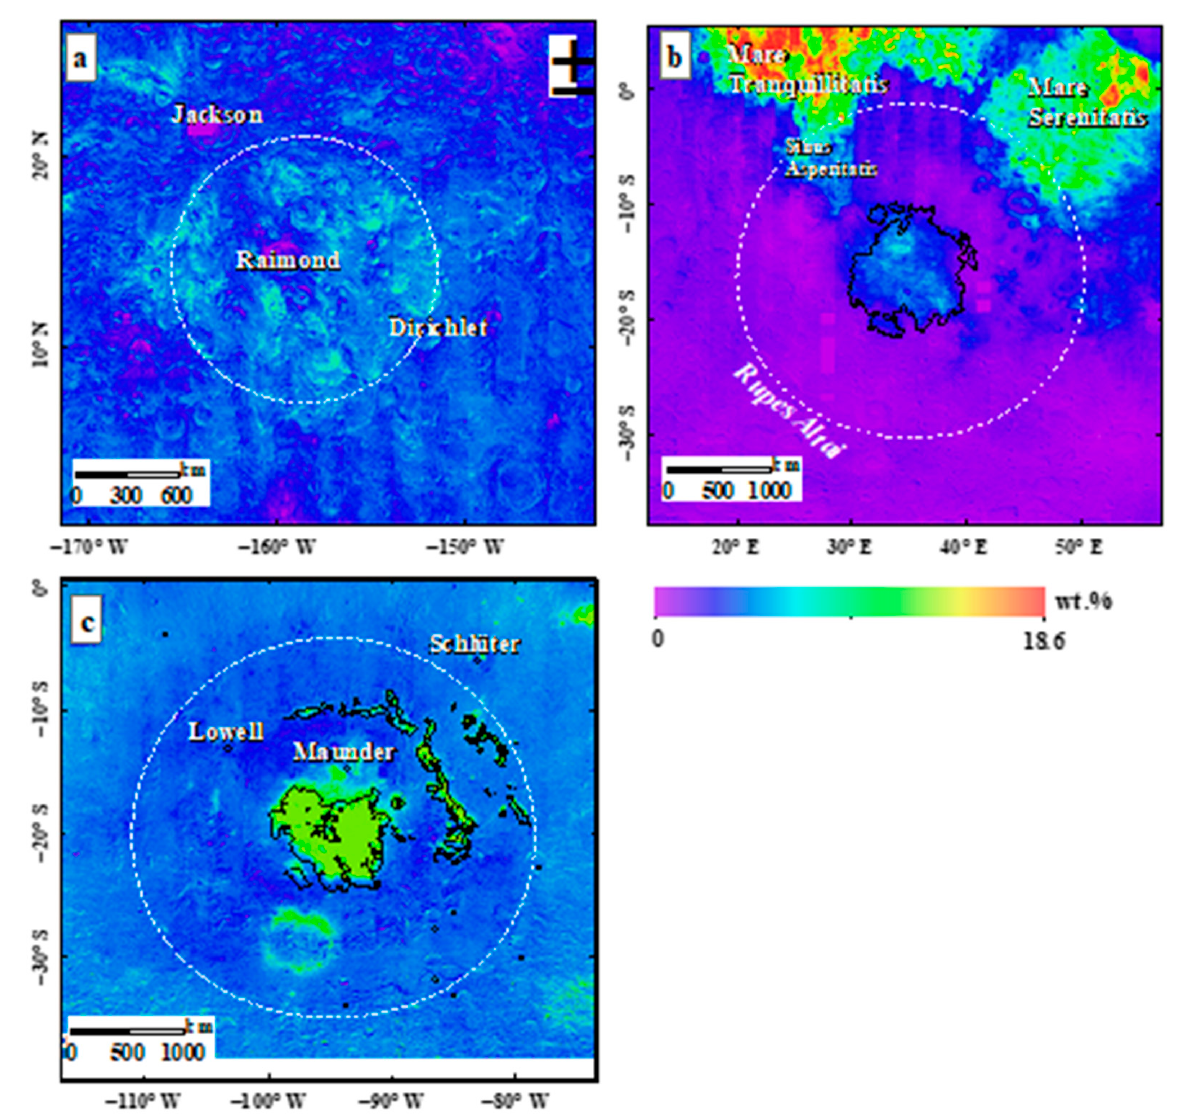
Figure 9. TiO 2 contents of Dirichlet–Jackson Basin ( a ), the Nectaris Basin ( b ), and the Orientale Basin ( c ). The black lines outline Maria in the Nectaris and Orientale basins. The map is in Mercator projec- tion. Table 2. Mean TiO 2 content in the sub-formations of the three basins.